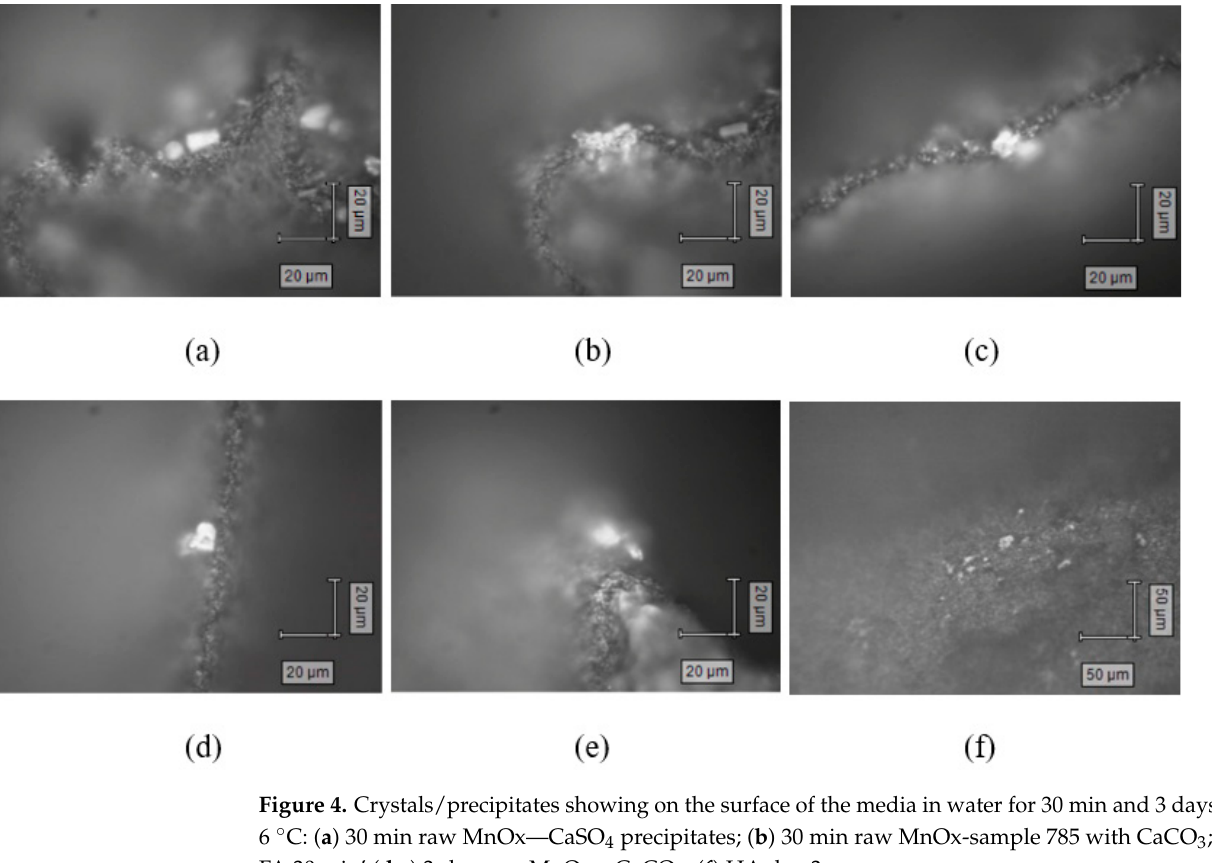
Figure 5. Sample R050128 (RRUFF, 2015) is a calcite, not a single crystal, with aragonite traces still present (black); HA Day 3 point 1 sample (blue) is a precipitate on the media pretreated with halo- acetic acid where media is submerged in water for 3 days; MnOx 30 min raw 785 (orange) where